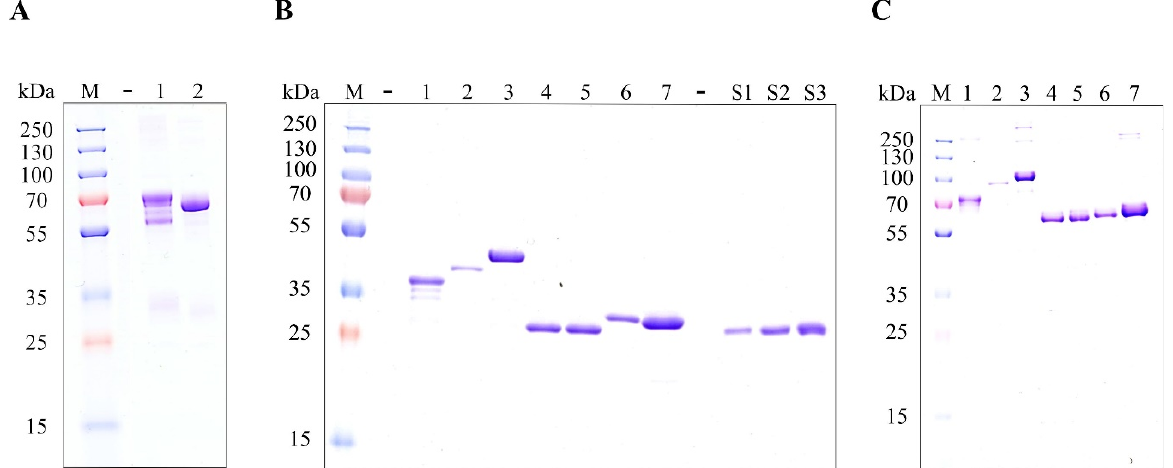
Figure 4. ( A ) SDS-PAGE analysis of wild type and mutant IgG 1 Fc region under non-reducing and NEM-treated conditions showing that the mutating the cysteines in the C H 3 domain to alanine results in the production of the IgG 1 Fc region in a single homogeneous redox state. M: protein marker, 1: IgG 1 Fc region wild type, Lane 2: IgG 1 Fc region (C250A, C308A). ( B ) SDS-PAGE gel image of Protein G-based purified POIs with a mutant IgG 1 Fc region (C250A, C308A) and purified wild type IgG 1 Fc region in three different concentrations under reducing conditions. ( C ) SDS-PAGE gel image of Protein G-based purified POIs with a mutant IgG 1 Fc region (C250A, C308A) under non-reducing and NEM-treated conditions showing that the fusion proteins are produced in a single homogeneous redox state. M: marker, 1: Trebananib, 2: Leptin–Fc, 3: hGH–Fc, 4: Angiotensin–Fc, 5: Substance P–Fc,